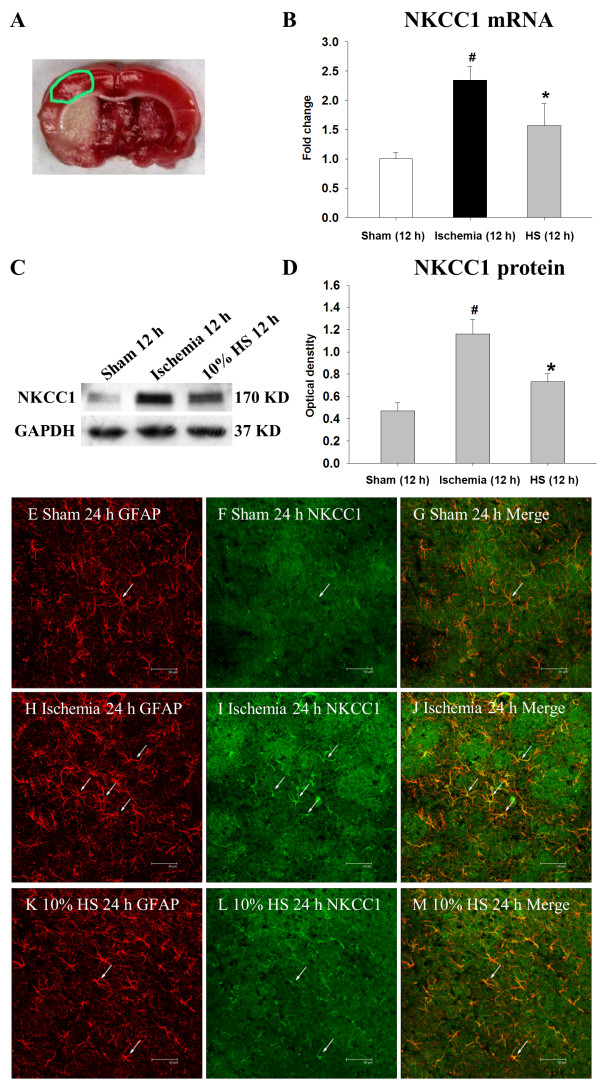
Ten percent HS down-regulated NKCC1 expression in peri-ischemic brain tissue. Sample was extracted from the peri-ischemic brain tissue outlined by the green line in (A). NKCC1 mRNA and protein expression in the peri-ischemic brain tissue of ischemic and ischemic + 10% HS rats at 12 h following MCAO and the corresponding control rats (sham-operated). Section (B) shows the graphical representation of the fold changes in NKCC1 mRNA in each group as quantified by normalization to the β-actin as an internal control (n = 6 per group). Section (C) shows NKCC1 (170 kDa) and GAPDH (37 kDa) immunoreactive bands, respectively. (D) This is a bar graph showing significant changes in the relative optical density of NKCC1 to GAPDH in each group. Significant differences in mRNA and protein levels in the peri-ischemic brain tissue of ischemic 12 h, ischemic 12 h + 10% HS are evident when compared with sham-operated ( # P <0.05,* P <0.05, n = 6 per group). Confocal images showing the distribution of GFAP labeled (E, H, K, red), and NKCC1 (F, I, L, green) immunoreactive astrocytes (arrows) in the peri-ischemic brain tissue of ischemic and ischemic + 10% HS rats at 24 h following MCAO and the corresponding control rats (sham-operated). GFAP labeling clearly overlaps NKCC1 immunofluorescence in (G, J and M). Note that NKCC1 expression in the perivascular astrocytes (arrows) is markedly enhanced following MCAO. After treatment with 10% HS, NKCC1 expression is noticeably attenuated. Scale bars: (E-M), 50 μm. GFAP, glial fibrillary acidic protein; HS, hypertonic saline; NKCC1, Na-K-Cl Cotransporter 1; MCAO, middle cerebral artery occlusion.